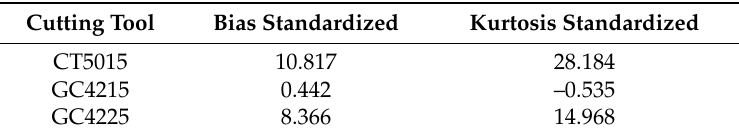
Table 4. Bias and Kurtosis standardized of the cutting tool wear.